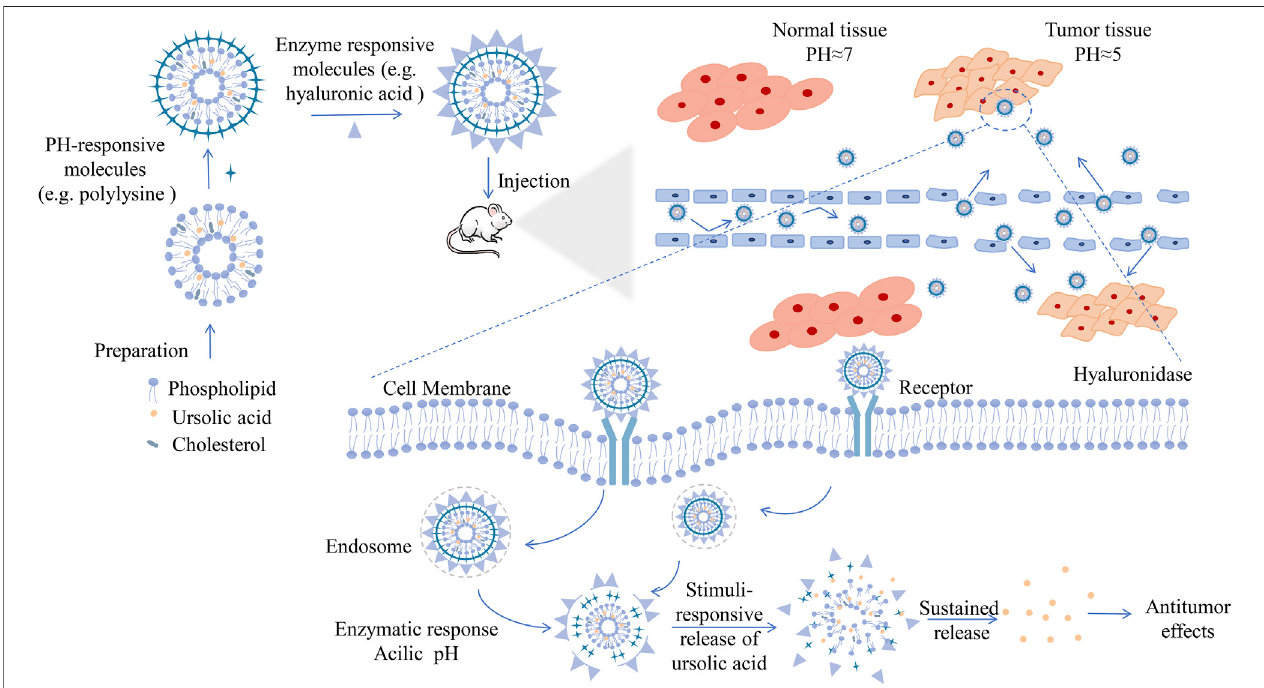
FIGURE 4 | Schematic diagram of UA nanoformulations from preparation to antitumor, e.g., double-responsive liposomes. Liposomes, similar to bio fi lm compositions, are membrane structure composed ofphospholipid bilayer and capable of chimeric cholesterol molecules, which can be prepared byclassical methods, such as fi lm hydration method, reverse-phase evaporation technique, or by other novel methods. As a hydrophobic drug, UA is located in the hydrophobic bilayer of phospholipid molecules. What ’ s more, stepped pH and high expression of metabolic enzymes are characteristics of tumor microenvironment. By reasonably stackingdifferentsurfacemodi fi cationmolecules,suchaspolylysineandhyaluronicacid,UAliposomeshavethedoubleresponsefunctionofpHandenzyme,whichcan better cope with the special changes of microenvironment in the process of delivery, and have stronger tissue targeting to achieve better therapeutic effect. Liposomes enter and accumulate in tumor tissue through the EPR effect, the same as other nanoformulations. Liposomes enter the interior of tumor cells through cell surface receptor-mediated endocytosis. Under enzymatic reaction and appropriate acidic pH, themodi fi ed liposomesdisintegrateand release the encapsulated UA molecules, playing an anti-tumor effect. Abbreviations: UA, ursolic